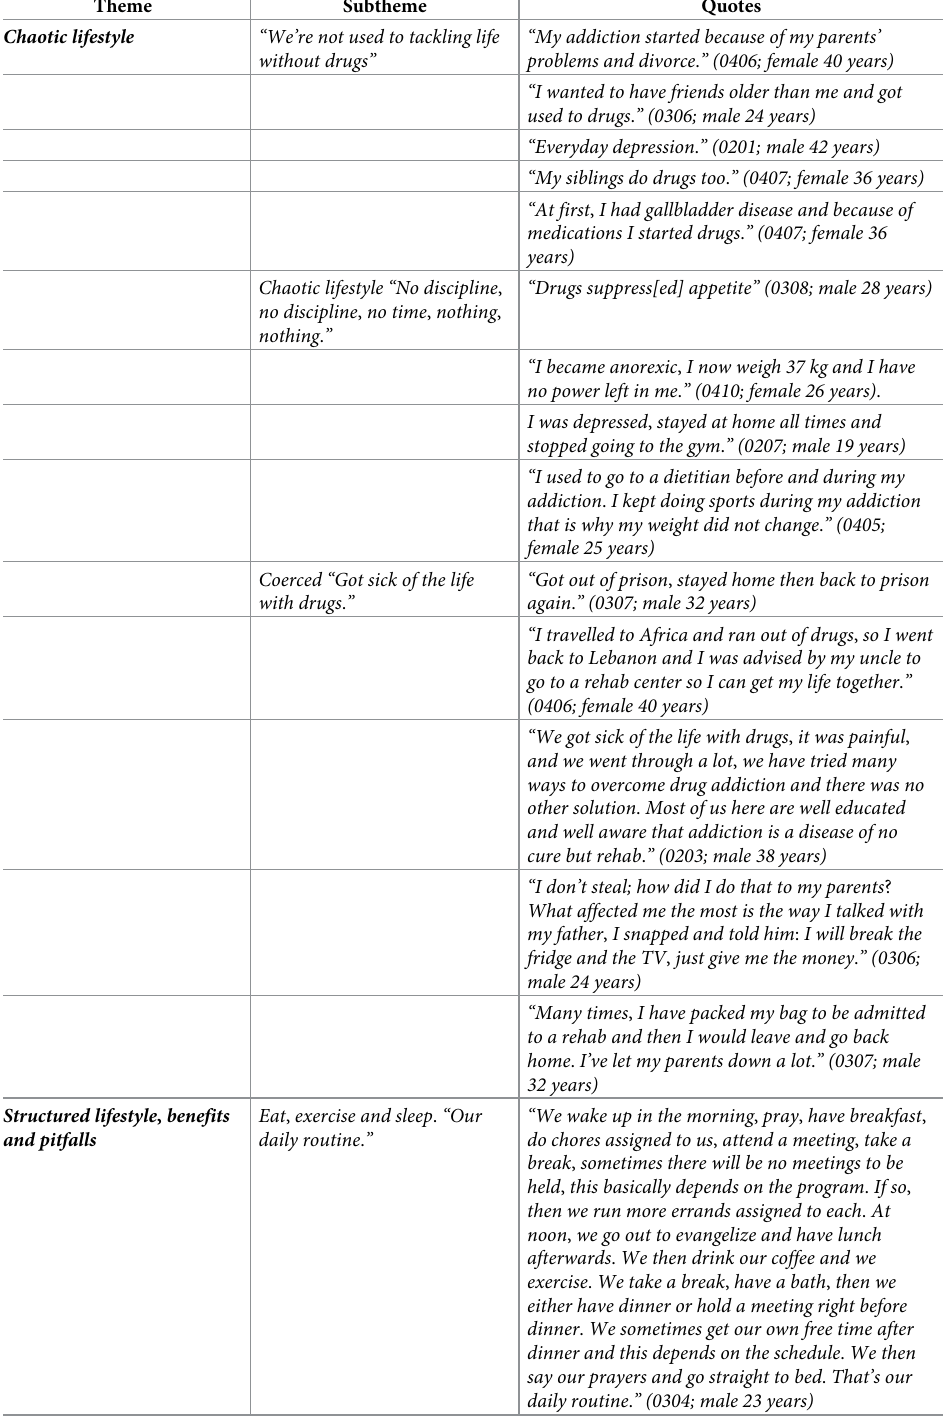
Table 2. Specific quotes corresponding to the themes and their